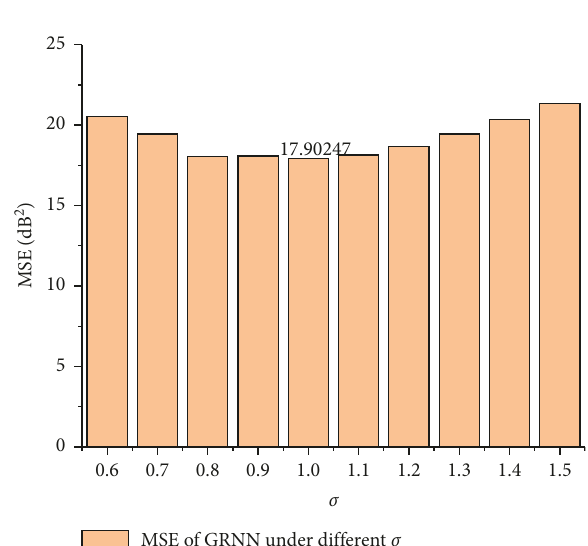
Figure 11: MSE of GRNN under different values of σ .